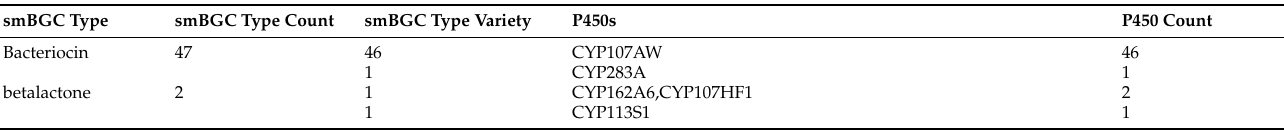
Table 4. Secondary metabolite biosynthetic gene cluster (smBGC) types and P450s are part of the cluster in Salinispora species. smBGC types were again classified into different varieties based on the P450s. The smBGCs type count and the total number of P450s in the cluster variety are also presented. The same smBGCs type names listed in the antibiotics and secondary metabolite analysis shell (anti-SMASH) database [74] were used in the table. Detailed information on secondary metabolite clusters, species, and P450s are shown in Table